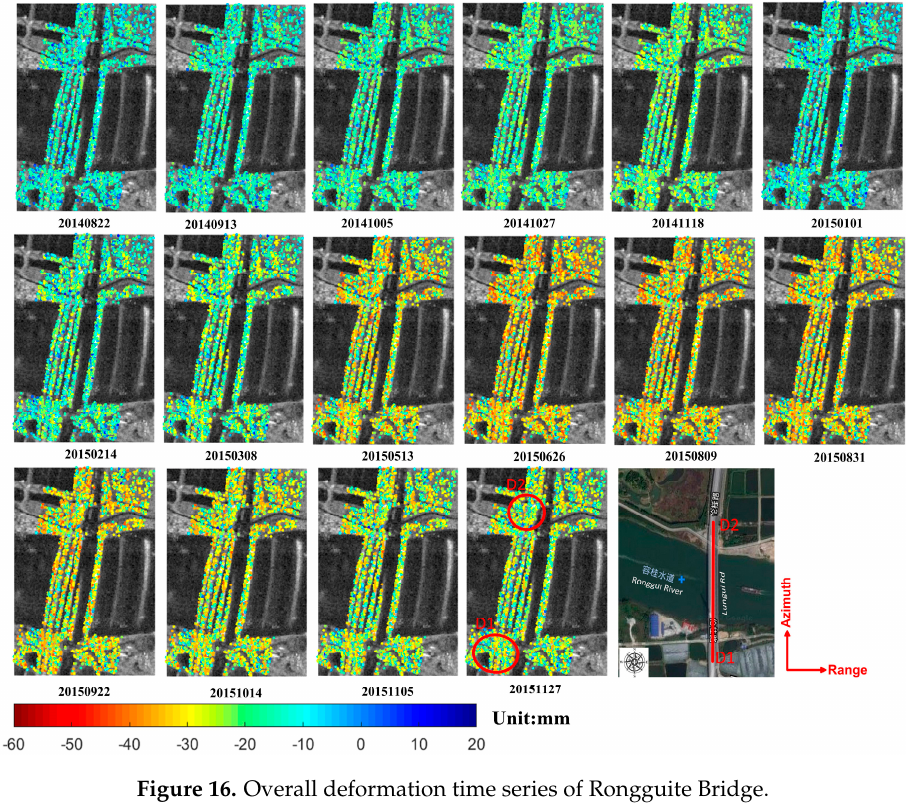
Figure 16. Overall deformation time series of Rongguite Bridge.